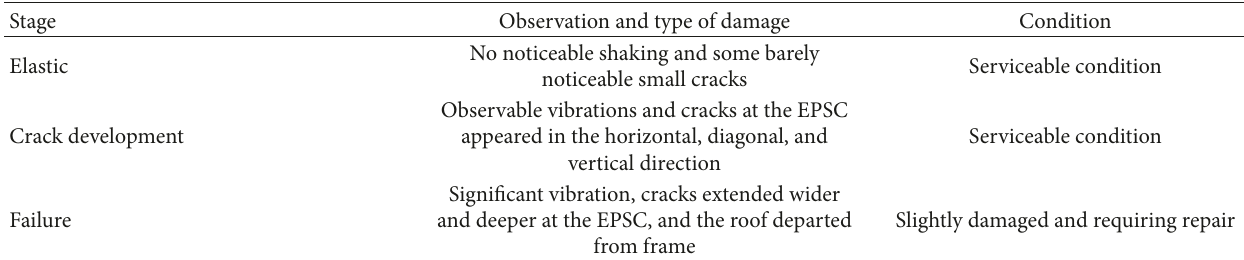
Table 4: Macroscopic phenomena of structure.